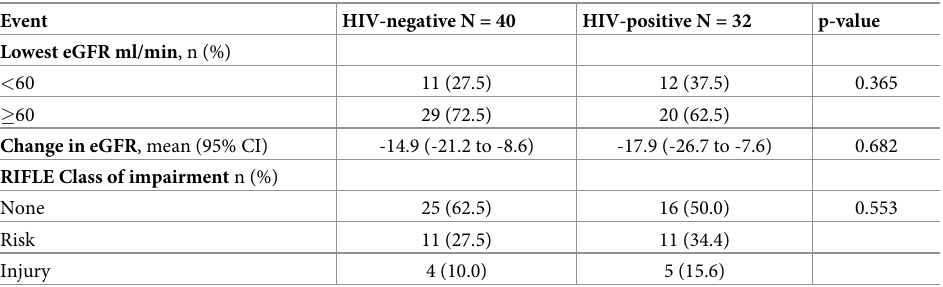
Table 2. Adverse renal events according to HIV status.